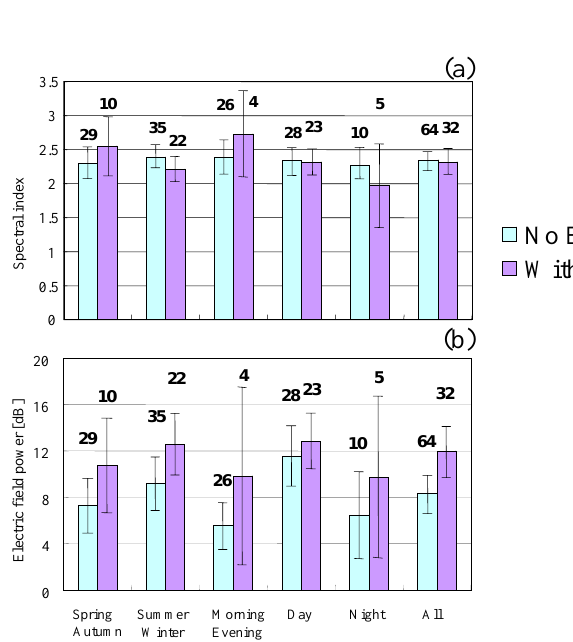
Fig. 6. Seasonal and local time dependence of the averaged ( a ) spectral index and ( b ) electric field power of the burst events. Shad- owed bins represent the bursts with major seismic activities and white bins are for the bursts without seismic activity. Error bars indicating the 95% confidence interval for each bin are calculated by using Gaussian distribution. Very large confidence intervals for groups (morning and evening, and nighttime) for seismic events are mainly due to the small number of events in the